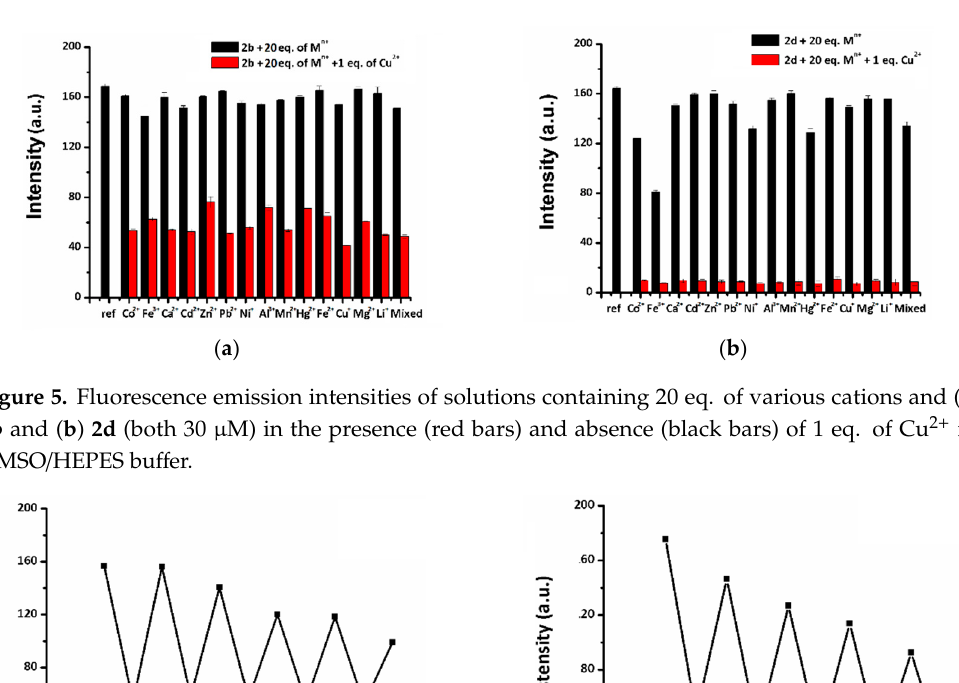
Figure 5. Fluorescence emission intensities of solutions containing 20 eq. of various cations and ( a ) 2b and ( b ) 2d (both 30 μ M) in the presence (red bars) and absence (black bars) of 1 eq. of Cu 2+ in DMSO/HEPES buffer.